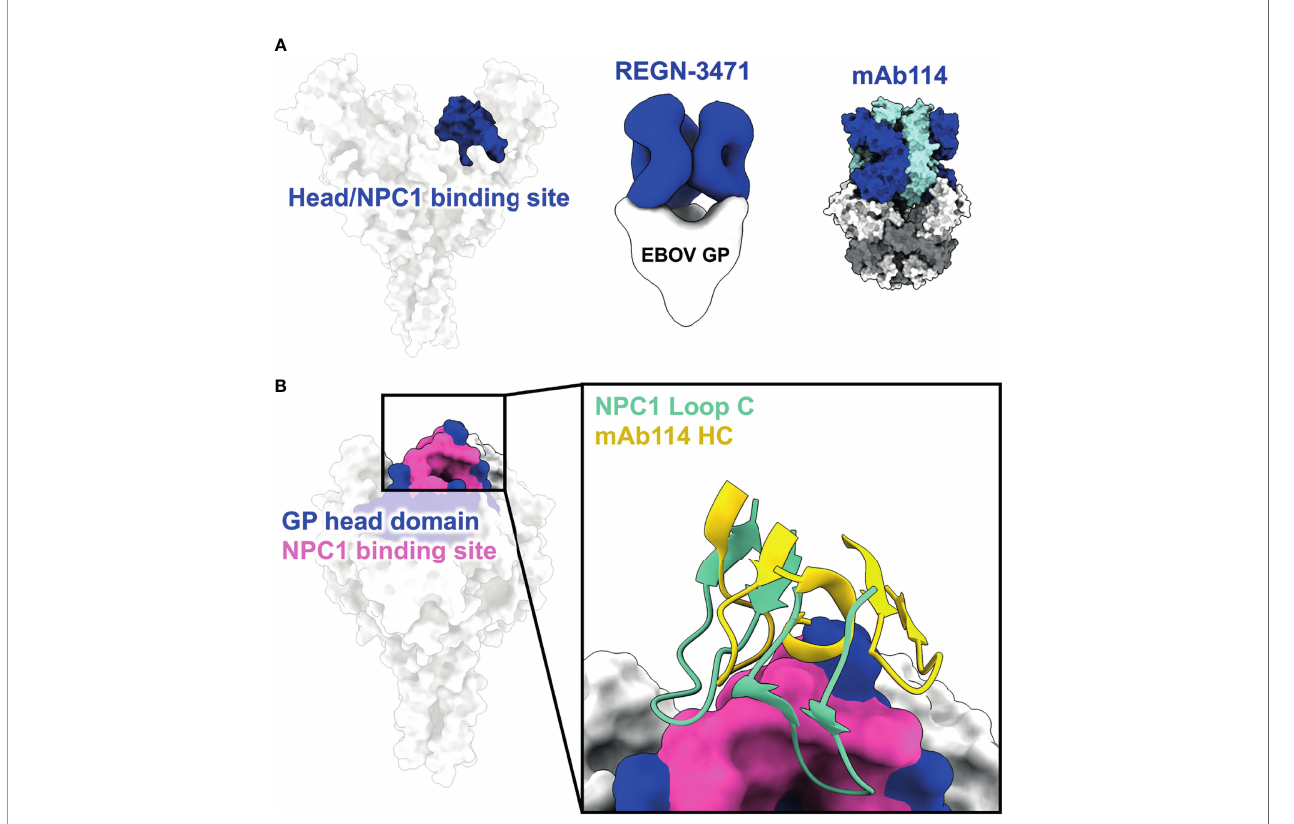
FIGURE 3 | The head domain and NPC1 binding site. (A) The head domain on GP sits below the glycan cap. Antibody Fabs of REGN-3471 (left, blue, EMD: 7902) and mAb114 (right, HC in blue and LC in cyan, PDBID: 5FHC) from two FDA-approved EBOV therapeutics access the head domain through very steep angles. (B) The NPC1 binding site (pink) necessary for viral entry lies within the head domain (blue). NPC1 binds to this region through its Loop C domain (turquoise), which is partially mimicked and blocked by the CDR loops of mAb114